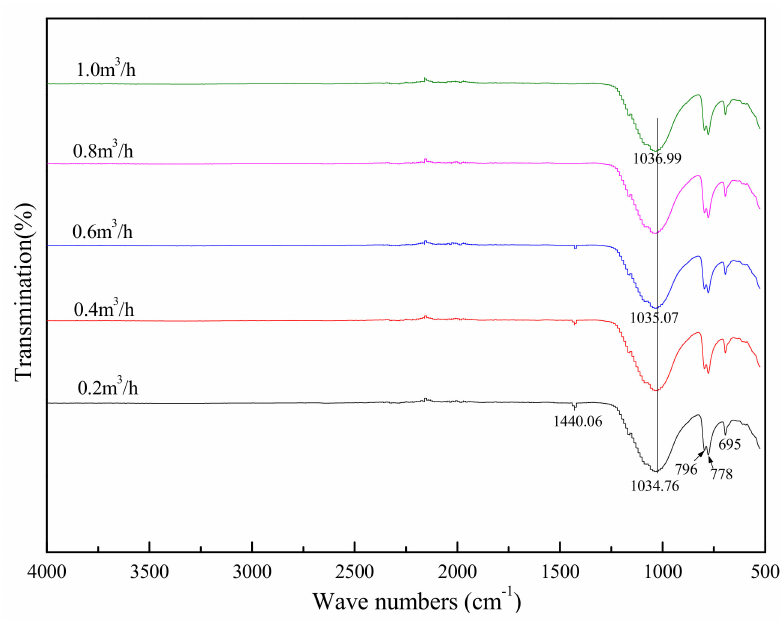
Figure 4. FTIR spectra of calcine at different ventilations.